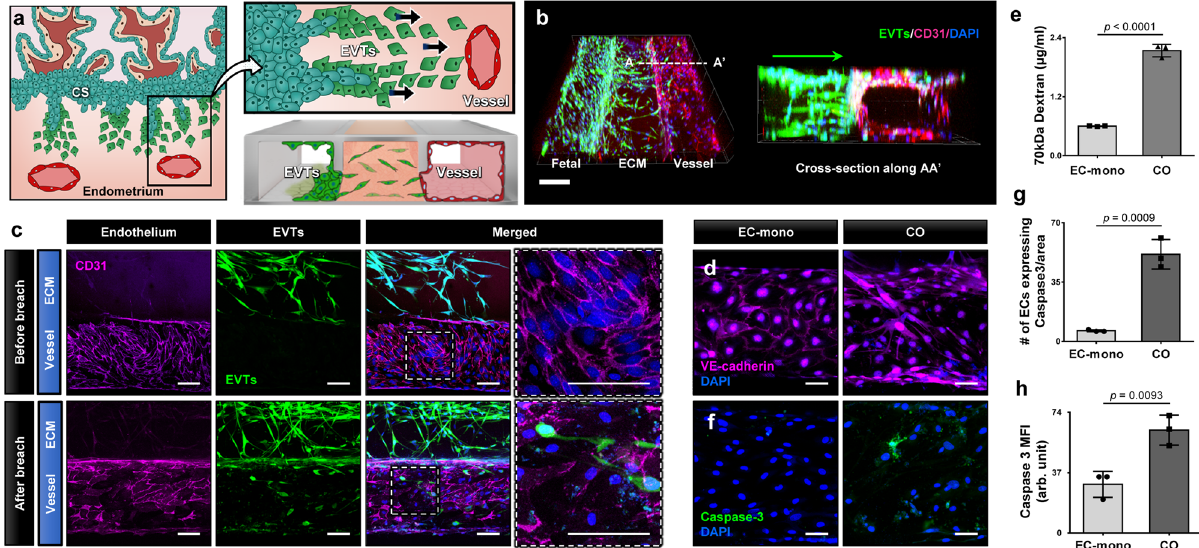
Fig. 4 Remodeling of maternal vessel in the implantation-on-a-chip. a Interactions between invading EVTs and maternal blood vessels were modeled in the implantation-on-a-chip. b 3D projection images of EVTs (green) migrating across the ECM hydrogel towards maternal ECs (magenta). The representative images are from three independent experiments. Scale bar, 200 μ m. c Invasion of the vascular endothelium by EVTs. Top and bottom panels show before and after endothelial breach, respectively. The representative images are from 3 independent experiments. Scale bars, 100 μ m. Comparison of vascular integrity in monoculture control (ECs only) and coculture (EVTs + ECs) models based on d immunostaining of adherens junctions (magenta) and e endothelial barrier permeability to 70 kDa FITC-dextran. The representative images are from three independent experiments. Two-sided t -test ( n = 3 independent devices per group). Blue in d shows nuclear staining. Scale bars, 50 μ m. f – h Visualization and quanti fi cation of caspase-3 (green) expression. Scale bars, 50 μ m. The representative images are from three independent experiments. Two-sided t-test ( n = 3 independent devices per group). Data are presented as mean ± SD. p values are shown on graphs. EC-mono: Endothelial cell monoculture, CO: EVT/EC coculture. Source data are provided as a Source Data fi